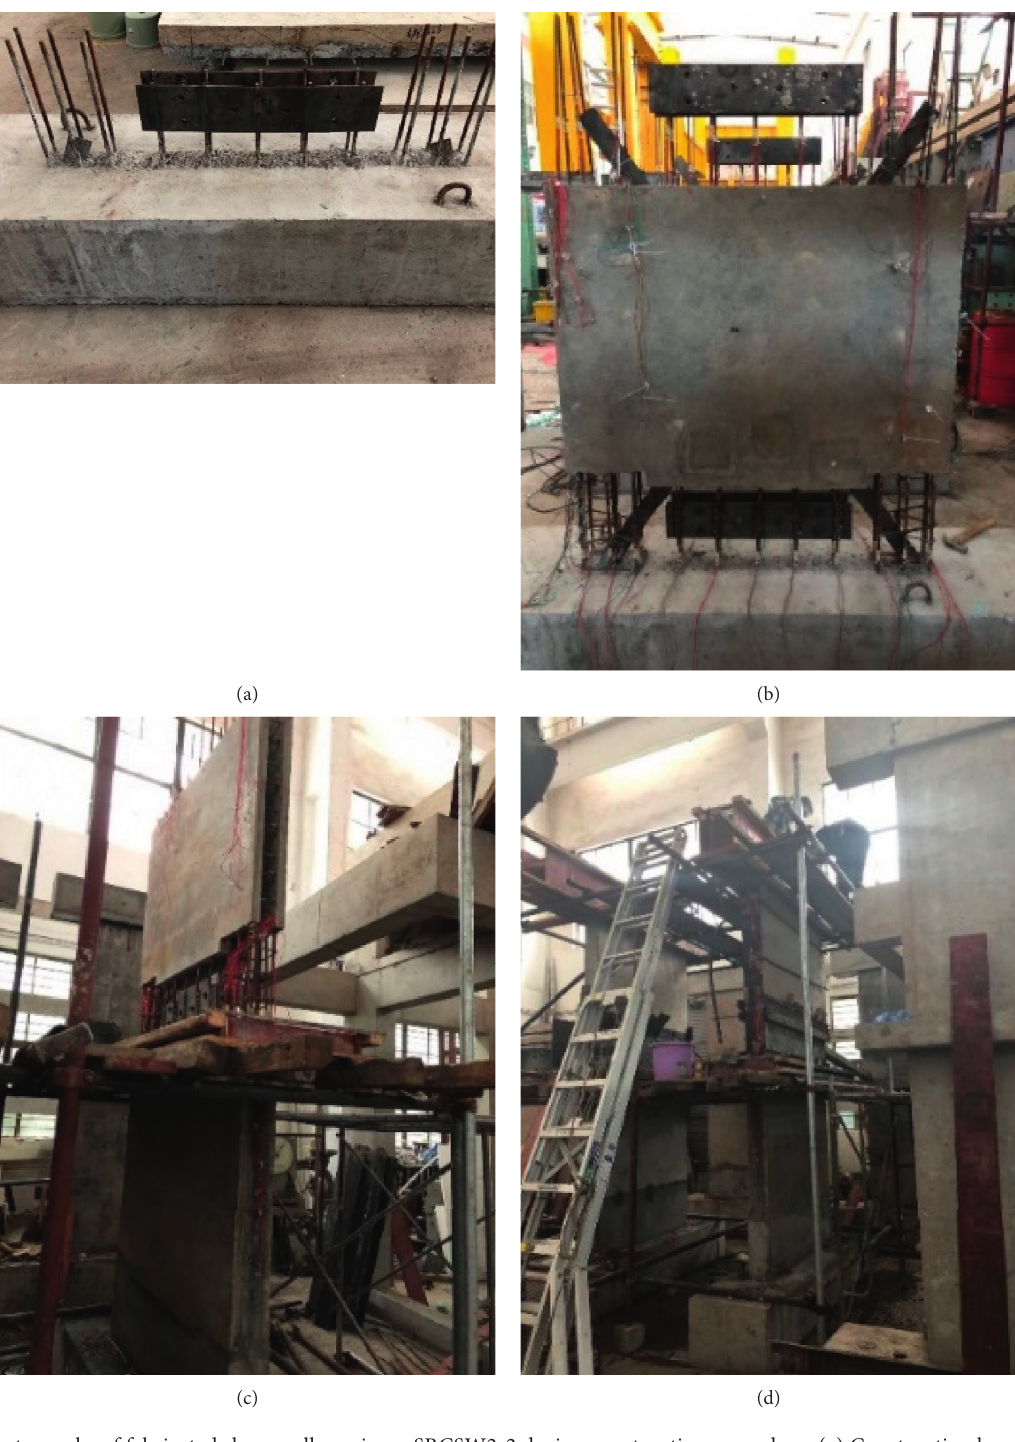
Figure 3: Photographs of fabricated shear wall specimen SRCSW2-2 during construction procedure. (a) Constructing base foundation. (b) Assembling PC wall segment of 1 st story. (c) Constructing floor slab and assembling PC wall segment of 2 nd story. (d) Casting the CIP layer of the 2 nd story together with the loading